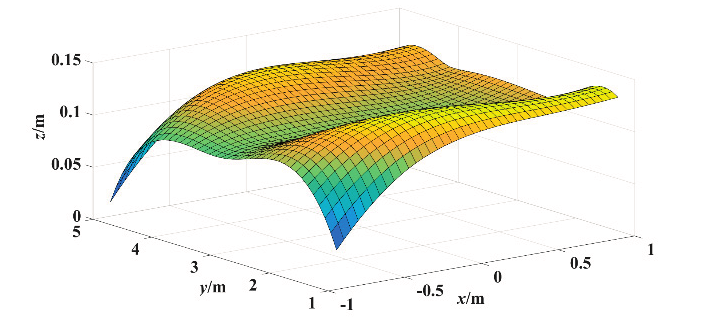
Figure 8. Error surface of plane localization with the miner’s lamp video collaborative localization.